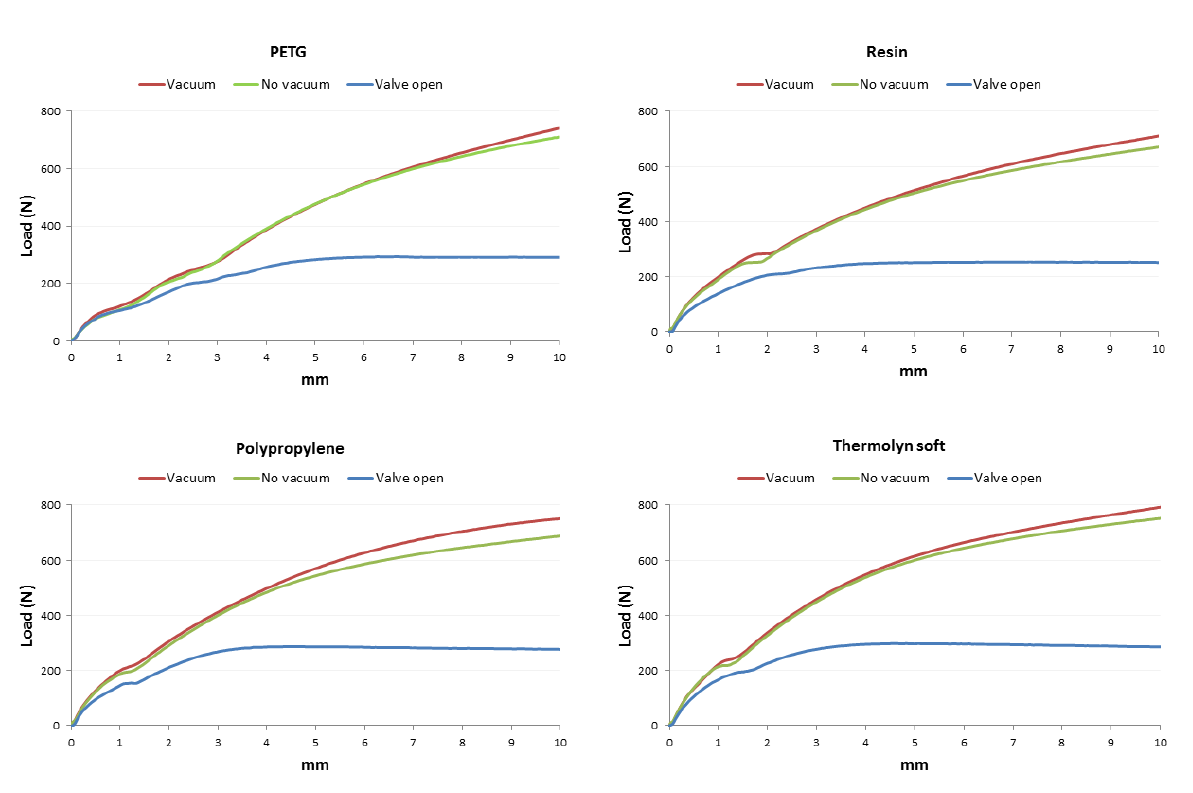
Figure 7: Average displacement (mm) and load (N) in cylindrical socket with Seal-In V standard